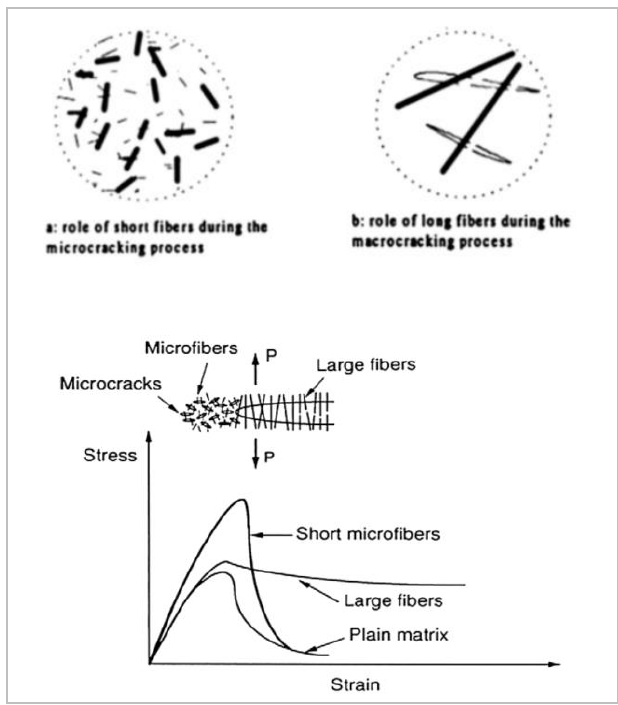
Figure 12. Role of macro- and micro-fibers during concrete fracture [49]. Reproduced from P. Rossi, Concrete International: 1982.